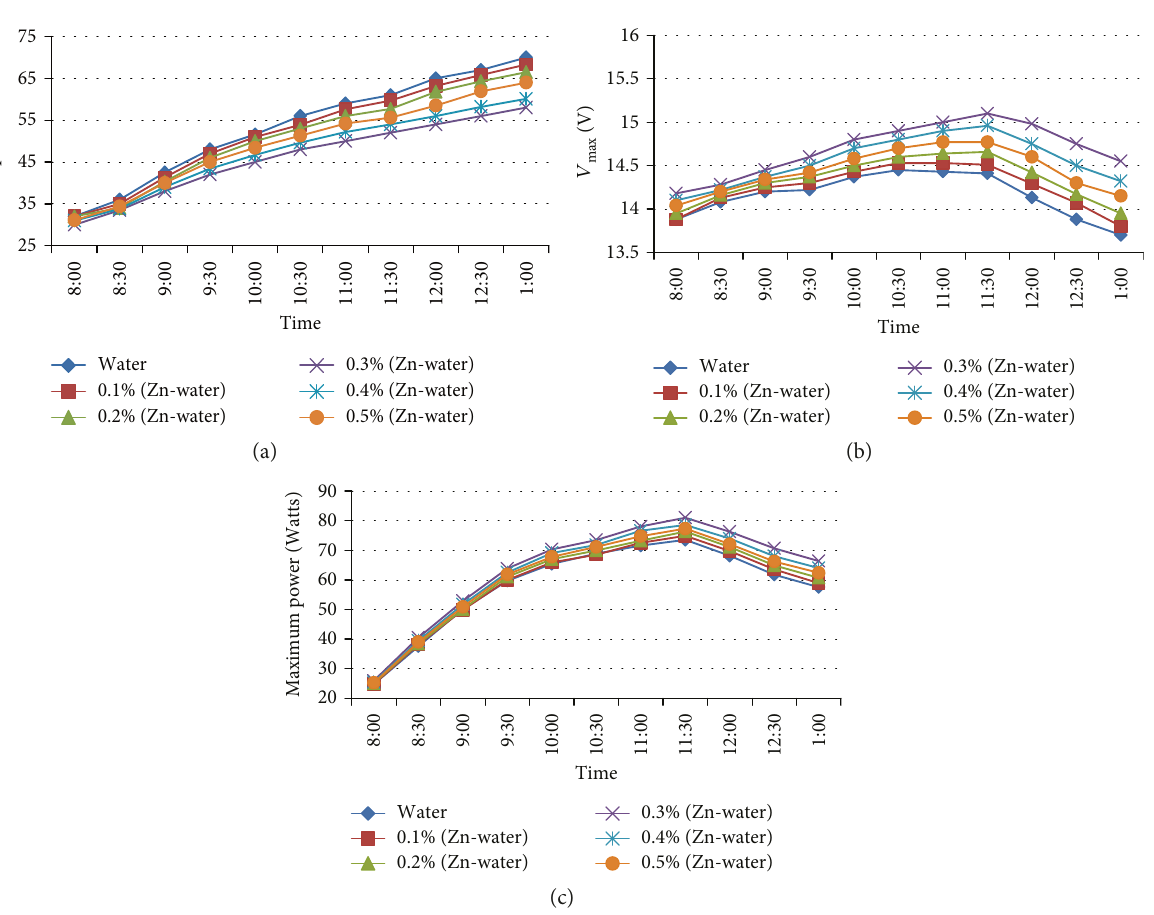
O nano fl uid at 2 L/min on the photovoltaic temperature. (b) E ff ect of Zn-H 2 O nano fl uid at 2L/min on the 2